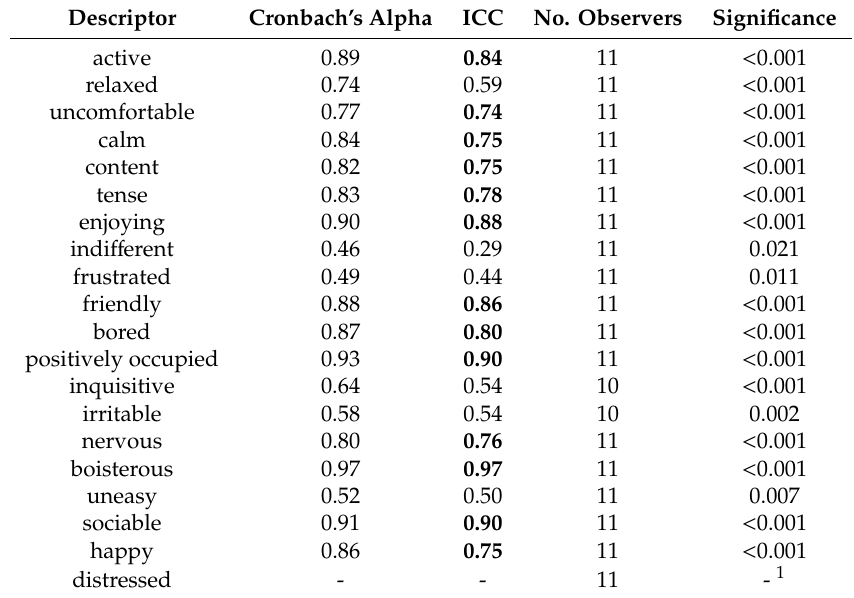
Table 2. Cronbach’s Alpha, intraclass correlation coe ffi cient (ICC), and number of agreements between observers for each descriptor used by the observers to assess the 20